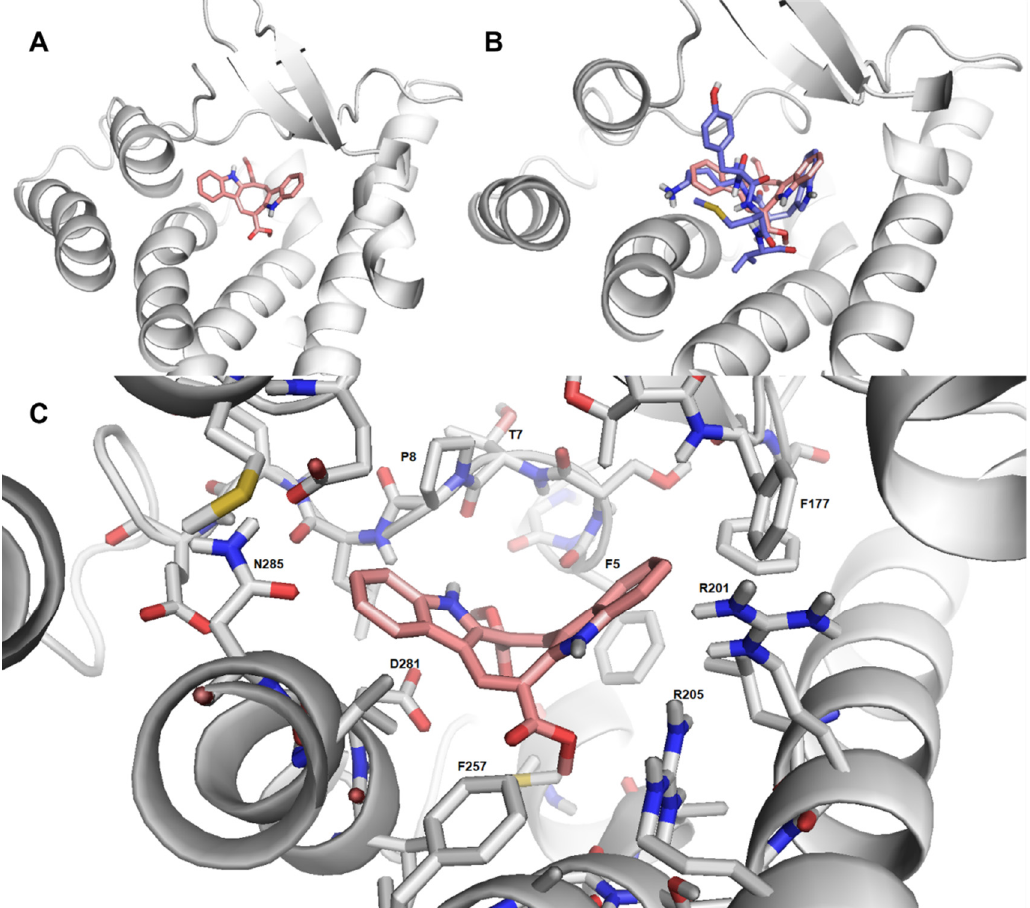
Figure 8. Cau interacts with FPR2, occupying its binding pocket. ( A ) Schematic representation of the complex FPR2-Cau. The receptor is represented in grey cartoon, while the ligand is shown in pink sticks. ( B ) Overall structure of the complex FPR2-Cau-WKYMV. The receptor is shown in grey cartoon, while the ligands are shown in pink or blue sticks, respectively. A partial overlap between Cau and WKYMV is shown. ( C ) Binding pocket of Cau in FPR2. The receptor is represented in grey cartoon, while the ligand is shown in pink sticks. The amino acids of the binding site are represented via grey sticks. Cau forms hydrophobic interaction with amino acids of the extracellular domain, I; II; III extracellular portion and VI transmembrane portion, which also constitute the WKYMV binding pocket.